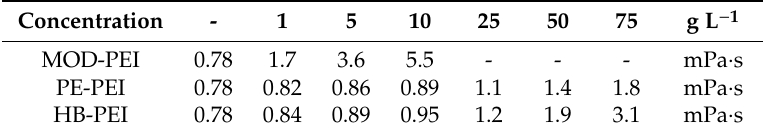
Table 3. Dynamic viscosity of aqueous PEI solutions (30 °C). Membrane-permeant size fraction was removed before measurement. Gel was formed with >20 g L − 1 MOD-PEI.